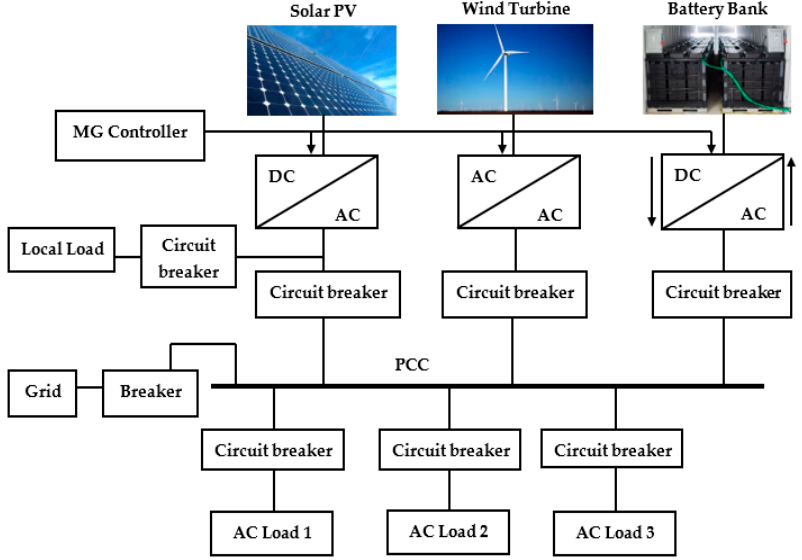
Figure 1. A basic structure of Microgrid [2].